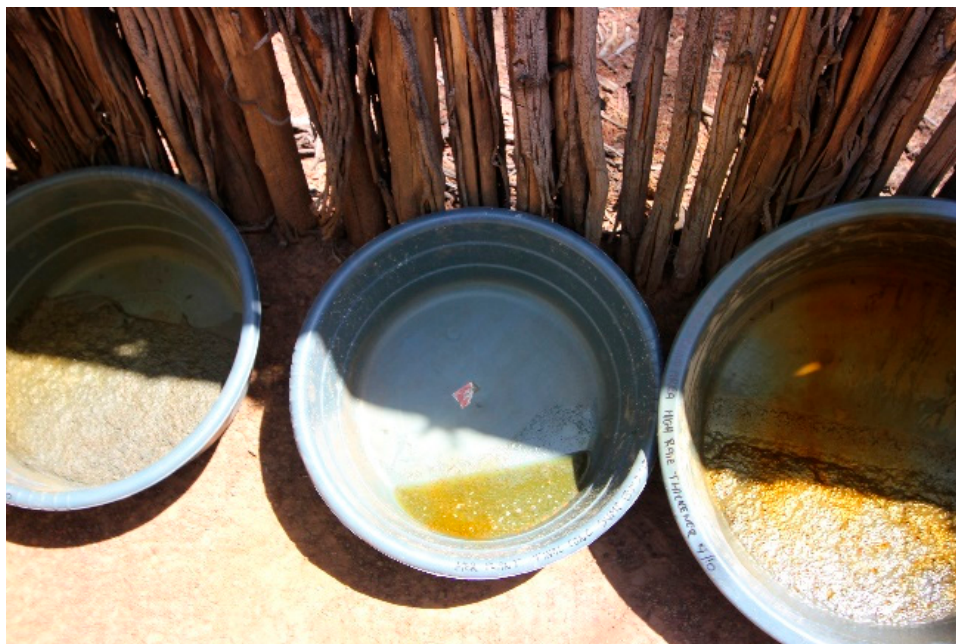
Figure 8. Nitric acid wash: photograph of the reaction of the nitric acid with materials containing abundant sulphides and silicates. Using this nitric acid wash for the illegal upgrading of concentrates is an unsafe practice. Although we applied the same method to replicate the results of this process, the informant was issued with appropriate personal protective equipment.